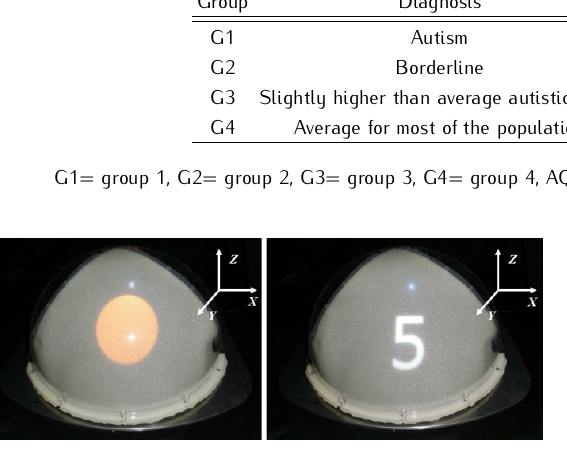
Figure 1. Touch Ball, examples in cases of colour and number feedback.